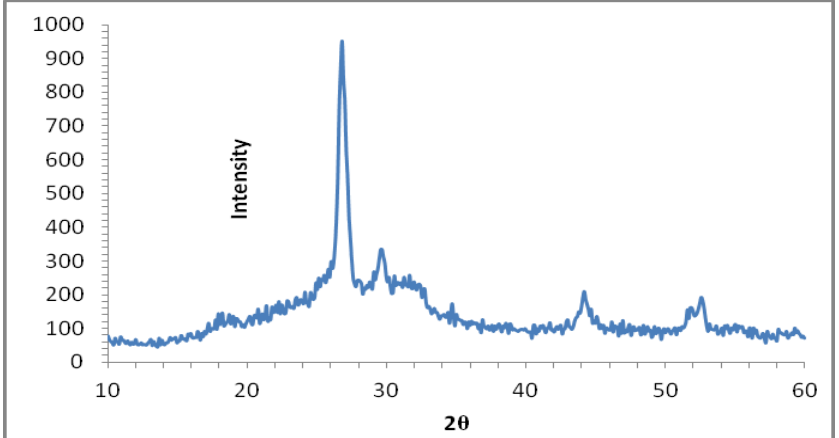
Fig. 2: X-ray diffraction pattern of annealed film obtain after three deposition at 400